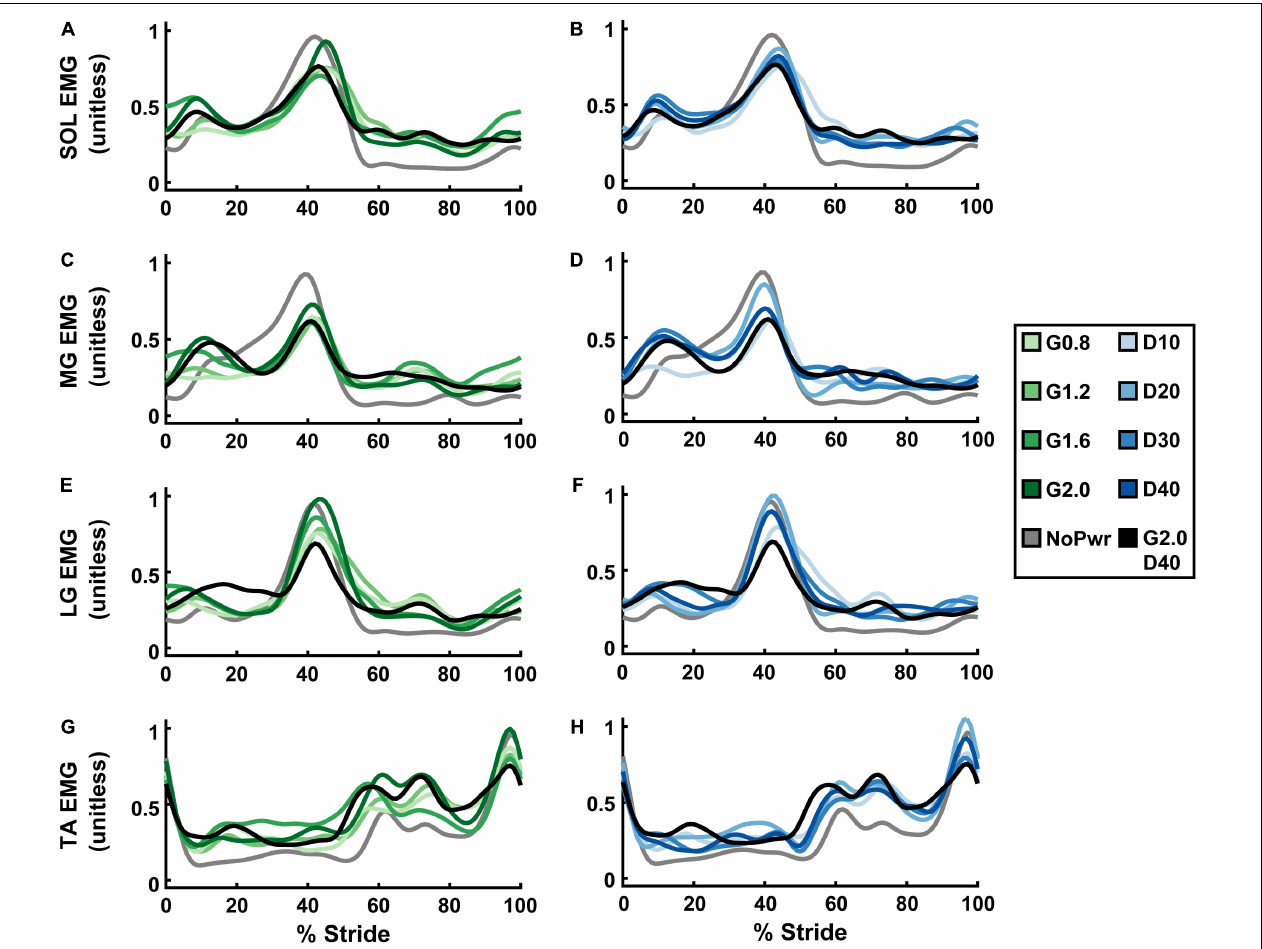
FIGURE 6 | Users’ ankle muscle activity over a stride cycle. Measurements of users’ normalized electromyography (EMG) signals recorded from soleus (SOL; A,B ), medial gastrocnemius (MG; C,D ), lateral gastrocnemius (LG; E,F ), and tibialis anterior (TA; G,H ) over a stride from heel strike (0%) to heel strike (100%) of the same leg are shown. All measurements are averages across the study participants ( N = 9) in each condition with varying neuromuscular model (NMM) controller reflex Gain (green) in left panel (A,C,E,G) and Delay (blue) in the right panel (B,D,F,H) . Conditions are abbreviated and color coded as follows: unpowered (NoPwr) (gray), NMM reflex Gains of 0.8, 1.2, 1.6, and 2.0 all with reflex Delay = 10 ms (G0.8, G1.2, G1.6, and G2.0, respectively) (green), NMM reflex Delays of 10, 20, 30, and 40 ms all with a reflex Gain = 1.2 (D10, D20, D30, D40, respectively) (blue), and a high-Gain-high-Delay condition (G2.0 D40)